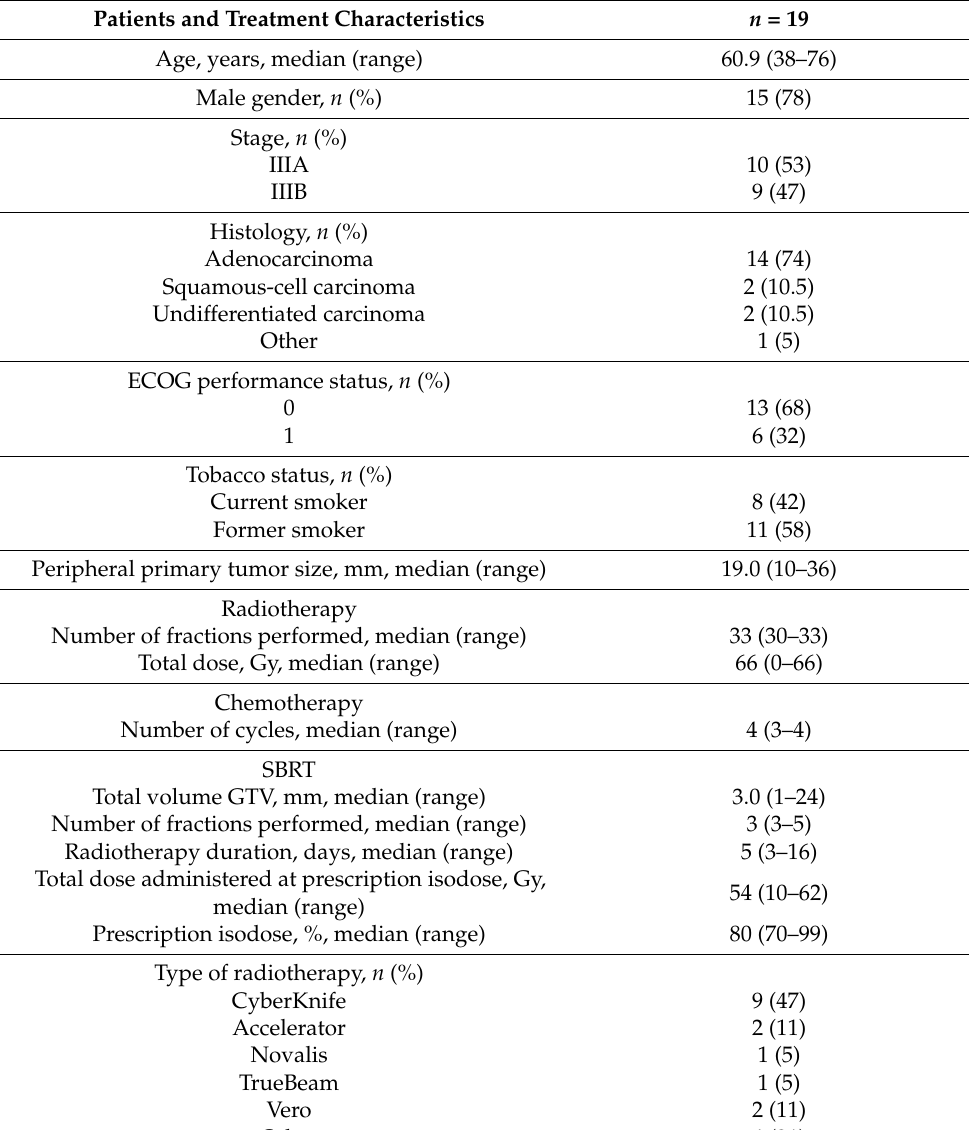
Table 1. Patient and treatment